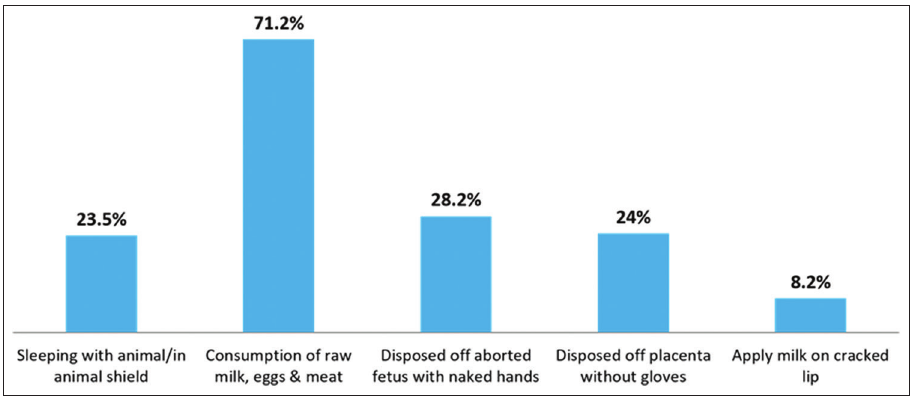
Figure-2: High-risk